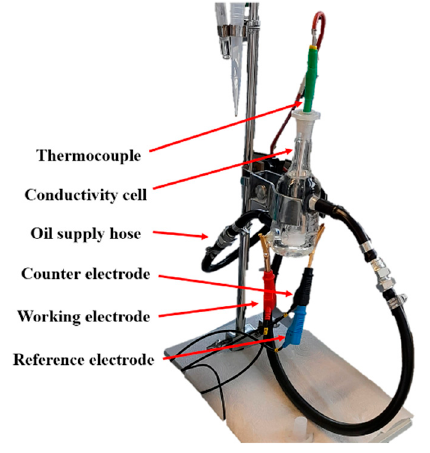
Figure 3. Device for conductivity measurement.